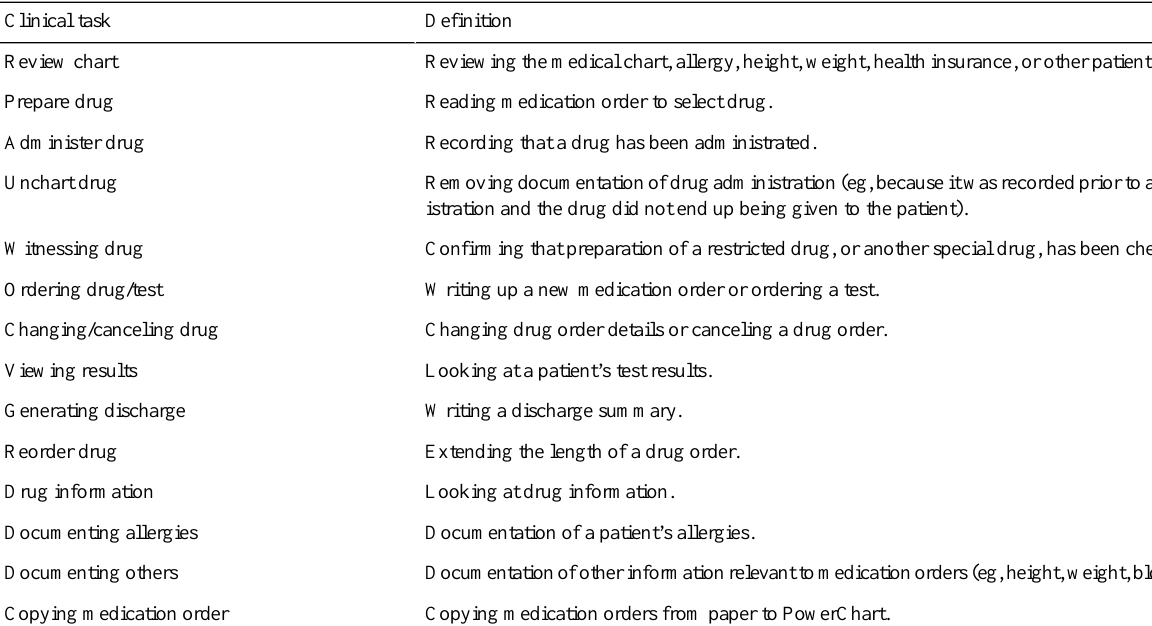
Table 1. Clinical task classification DefinitionClinical